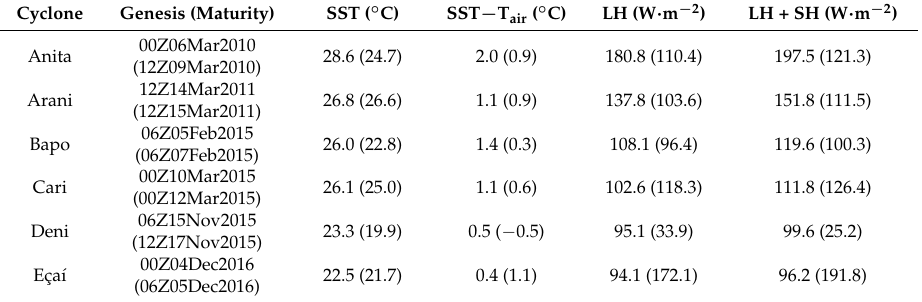
Table 3. Date of genesis (time of the first close isobar in the sea-level pressure field) and maturity (time of the most intense cyclonic relative vorticity in the vertical column) and box mean (10 ◦ × 10 ◦ of latitude by longitude from the cyclone center) of the variables (sea surface temperature (SST), near-surface latent (LH) and latent plus sensible heat fluxes (LH+SH), and difference between SST and air temperature at 2 m) for each subtropical cyclone. Values during the maturity phase are in parentheses.